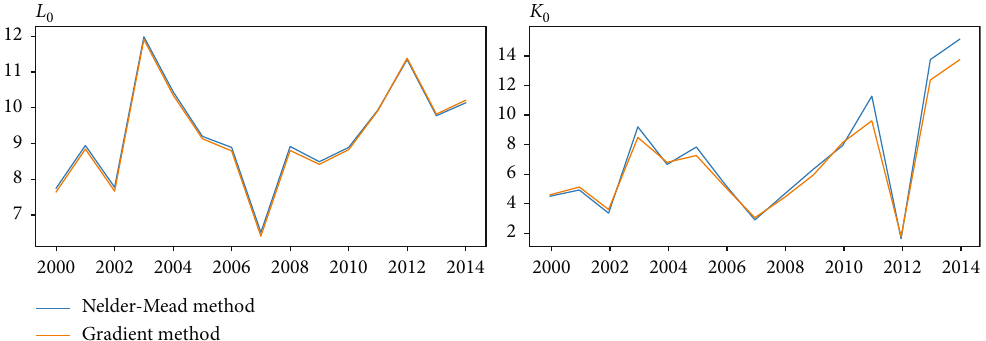
k 0 of oil products at the hydrological station the Dobyn pier